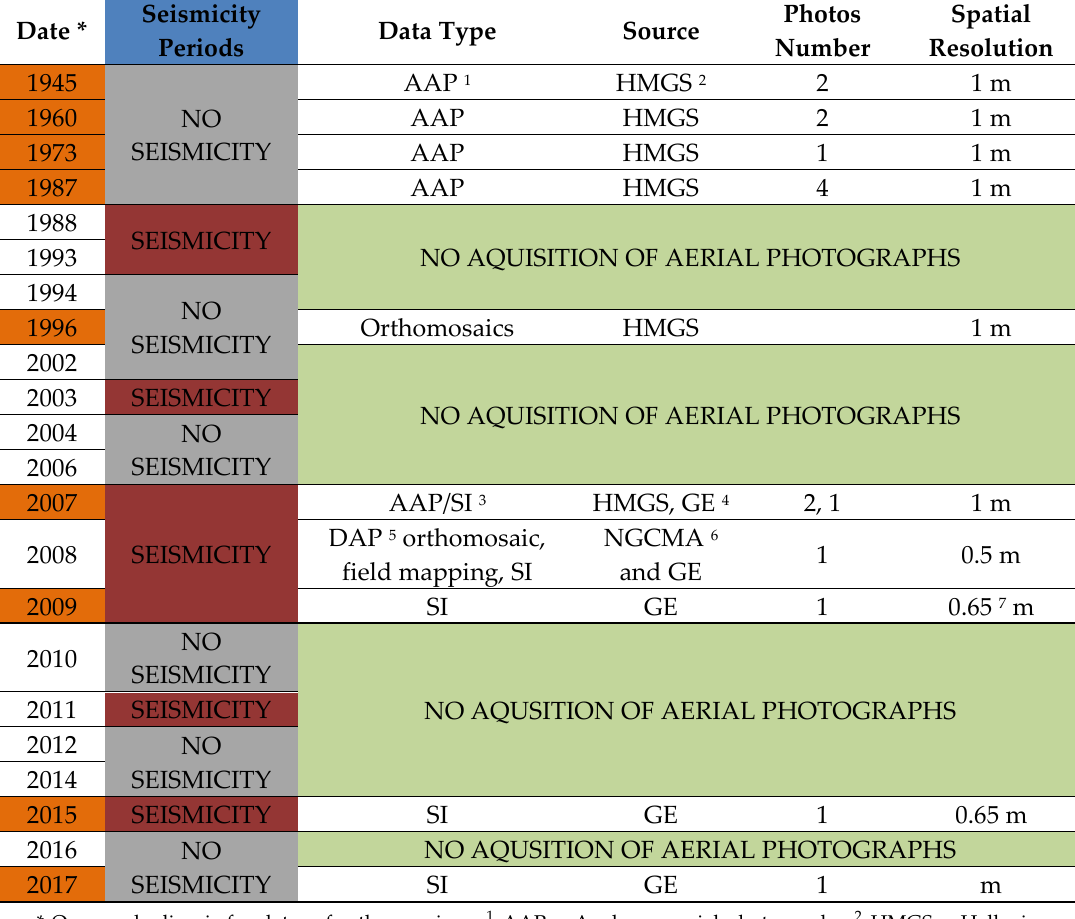
Table 1. Seismicity and spatial resolution of the analogue aerial photographs (AAP), digital aerial